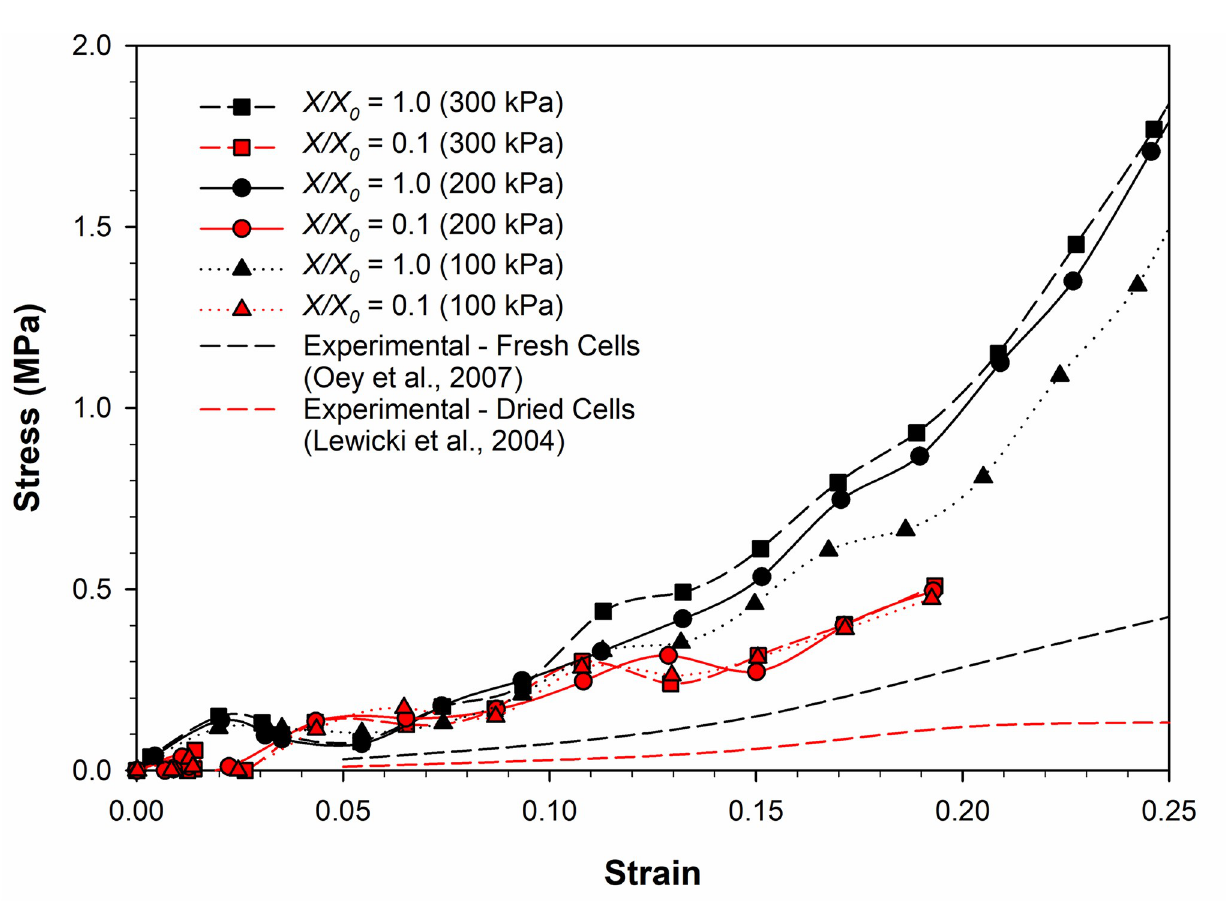
Fig 10. The stress-strain relationship of fresh ( X/X High: 300 kPa, Low: 100 kPa) ( X/X 0 is the normalised moisture content).